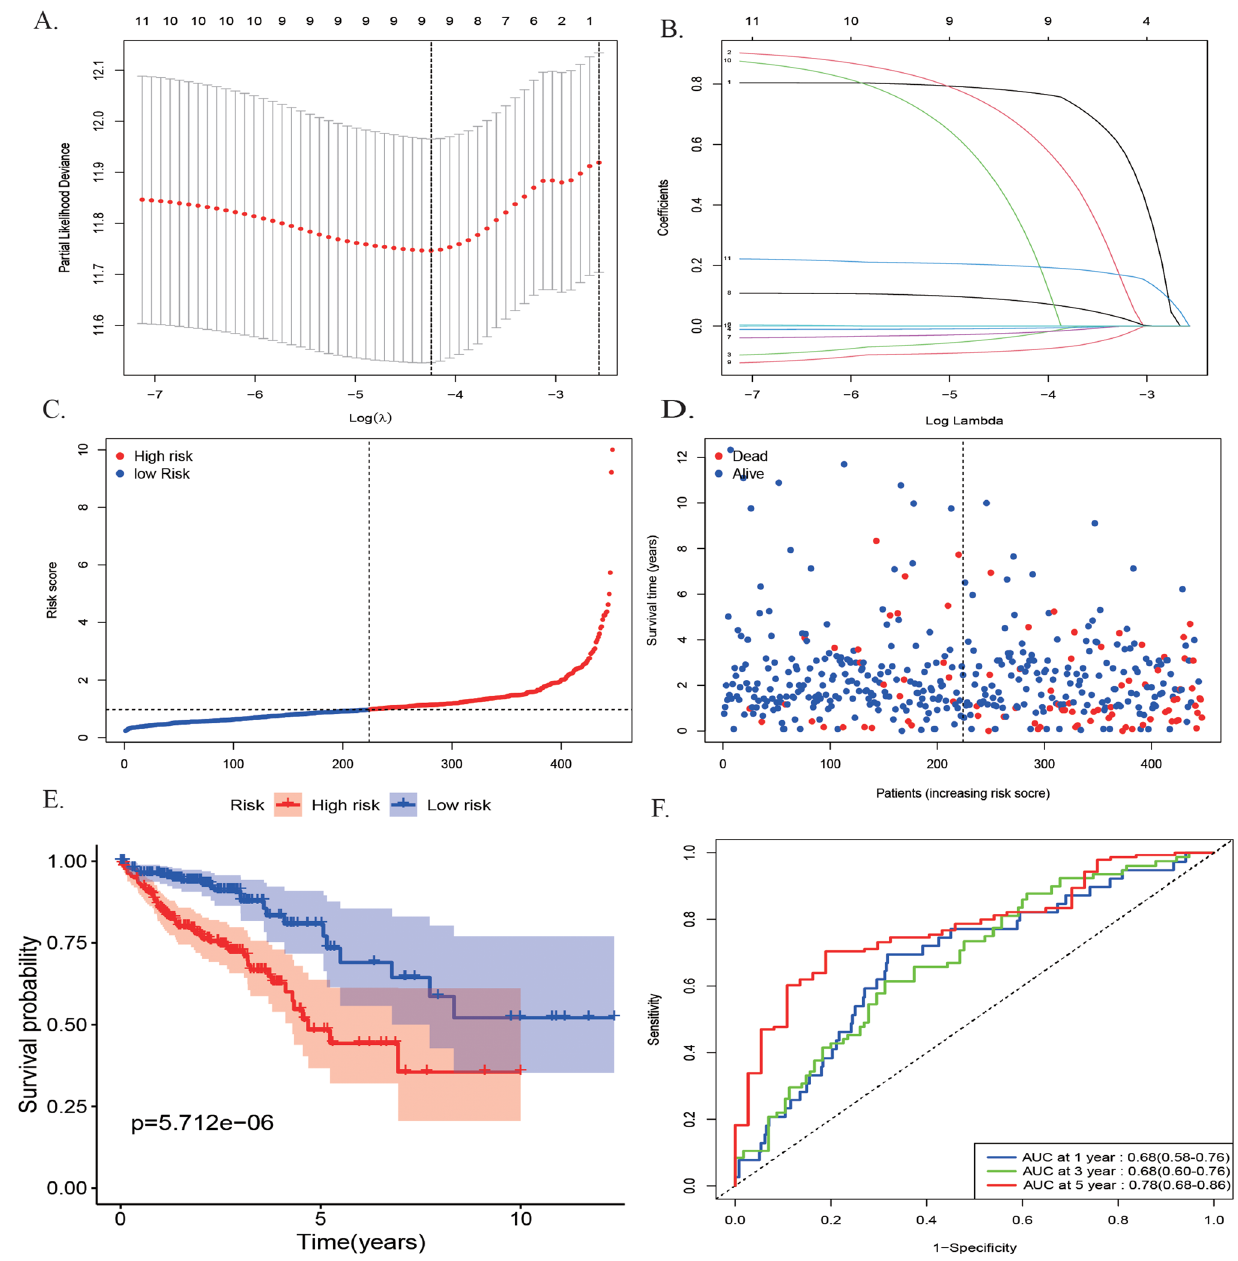
Figure 3. Construction of a prognostic model in TCGA by LASSO Cox regression analysis. (A,B) Selection of the optimal parameter (lambda) in the LASSO model for colorectal cancer. (C) The distribution of risk score and patient’s survival time. The black dotted line is the optimum cutoff dividing patients into low-risk and high- risk groups. The red curve represents high risk and the blue curve represents low risk. (D) The distribution of risk score and patient’s survival status. (E) The high-risk score was related to poorer OS. F ROC analysis of the sensitivity and specificity of the